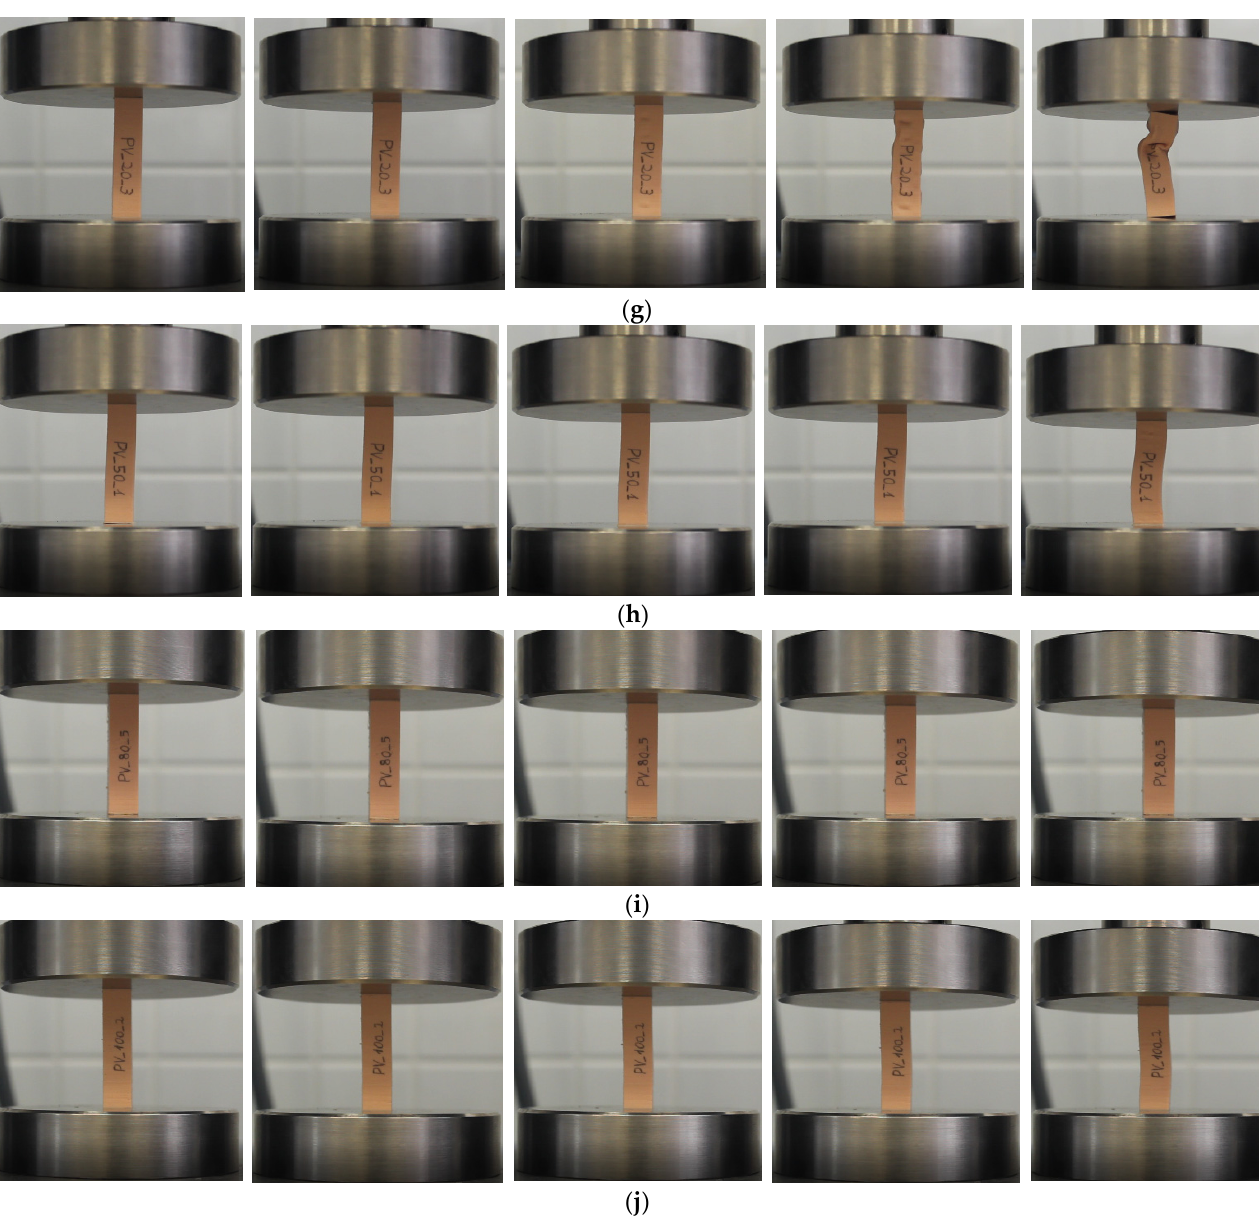
Figure A2. Test video with vertical specimens: ( a ) CV 0%; ( b ) CV 20%; ( c ) CV 50%; ( d ) CV 80%; ( e ) CV 100%; ( f ) PV 0%; ( g ) PV 20%; ( h ) PV 50%; ( i ) PV 80%; ( j ) PV 100%.